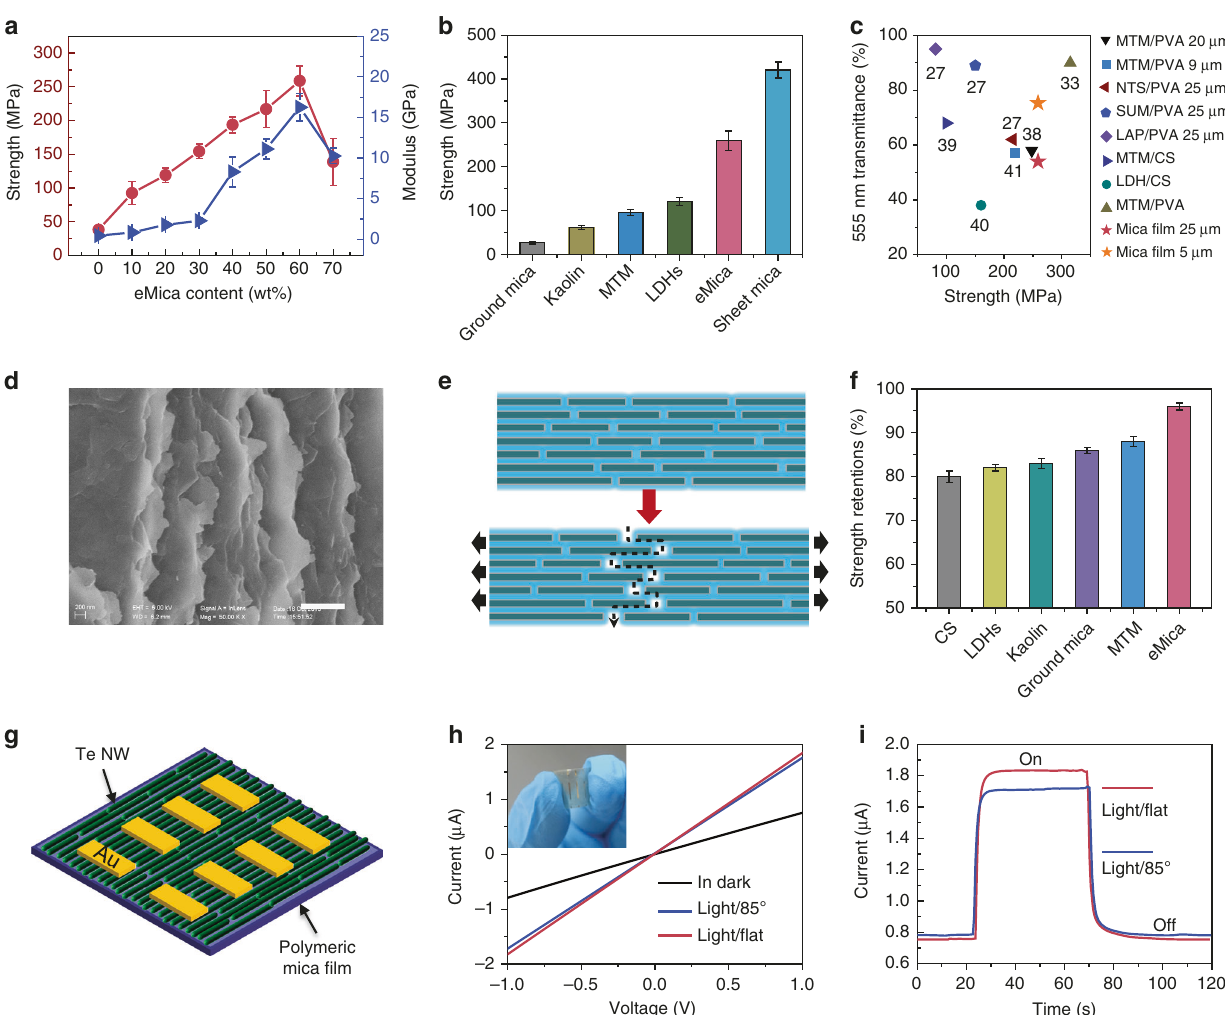
Fig. 4 Mechanical performance investigation and fl exible and transparent device fabrication. a In fl uence of eMica nanosheet content on the tensile strength and Young ’ s modulus of these fi lms. b Comparison of the tensile strength of 60 wt.% polymeric mica fi lm, sheet mica, and other as-prepared nacre-like competitors with same thickness (~25 µ m). c Comparison of strength and transmittance at 555 nm of the 60 wt.% polymeric mica fi lm and other nanoclay- based biomimetic composite fi lms 27,33,38 – 41 . d Fracture morphology of the 60 wt.% polymeric mica fi lm after tensile testing. Scale bar, 800 nm. e Proposed synergistic mechanical enhancement mechanism of the 60 wt.% polymeric mica fi lm. f Retention of the tensile strength of 60 wt.% polymeric mica and other as-prepared nacre-like competitors after UV irradiation for 144 h. g Schematic illustration of the device with 60 wt.% polymeric mica fi lm as its substrate. h Typical I – V curves of the device measured in the dark and upon light illumination (450 nm, 180 mW cm − 2 , fl at and bent). Inset shows a photograph of a bent device. i Time response spectrum of the device to pulsed light at V = 1 V. All the error bars represent the s.d. of at least fi ve